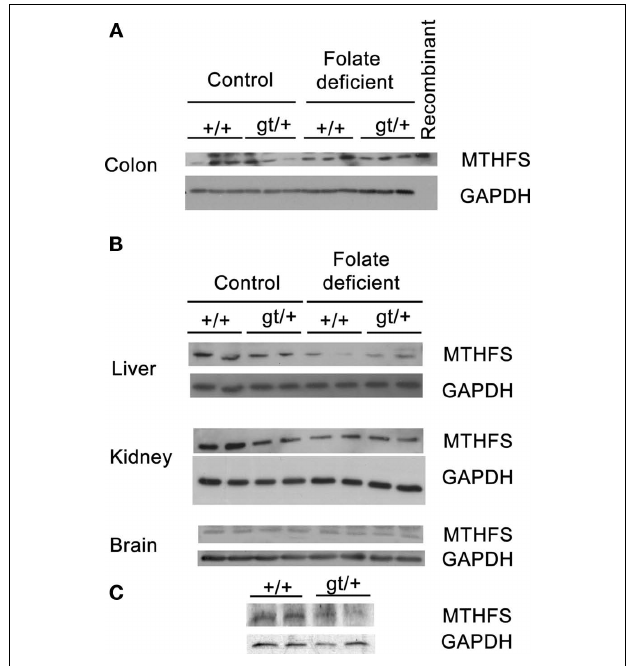
FIGURE 4 |Western blot of Mthfs + / + and Mthfs gt/ + tissues. Tissue lysates from liver, kidney, colon (25 μ g total protein per lane), and brain (50 μ g total protein per lane) were separated on a 10% SDS-PAGE gel. Membranes were probed with sheep anti-mouse MTHFS antibody (described in section Materials and methods). Glycerol aldehyde phosphate dehydrogenase (GAPDH) was used as a loading control. (A) Three samples per genotype and diet were run for colon, and this blot includes mouse recombinant MTHFS (purified as described previously Anguera and Stover, 2006). (B) Two samples were run per genotype per diet for liver, kidney and brain. (C) Cell lysates from Mthfs + / + and Mthfs gt/ + MEF cells, n = 2 cell lines per genotype.